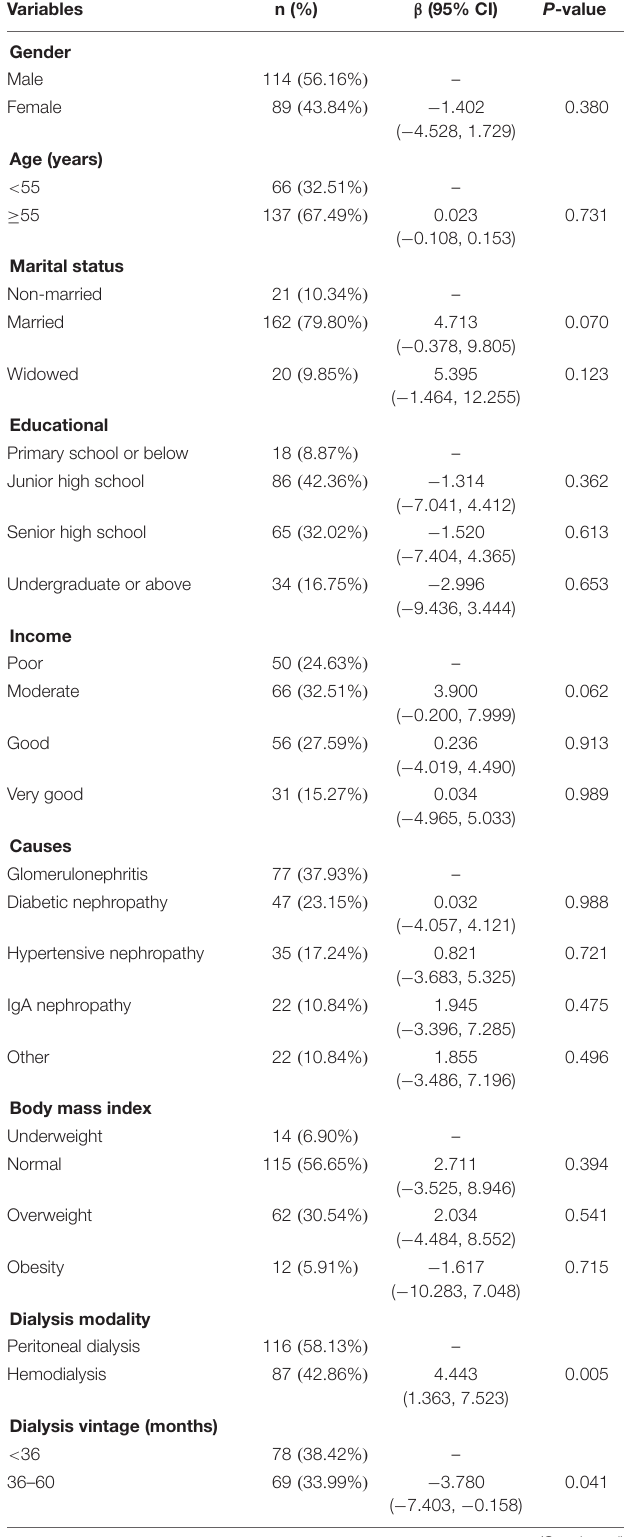
TABLE 1 | Characteristics of included patients according to socio-demographic variables ( n = 203).